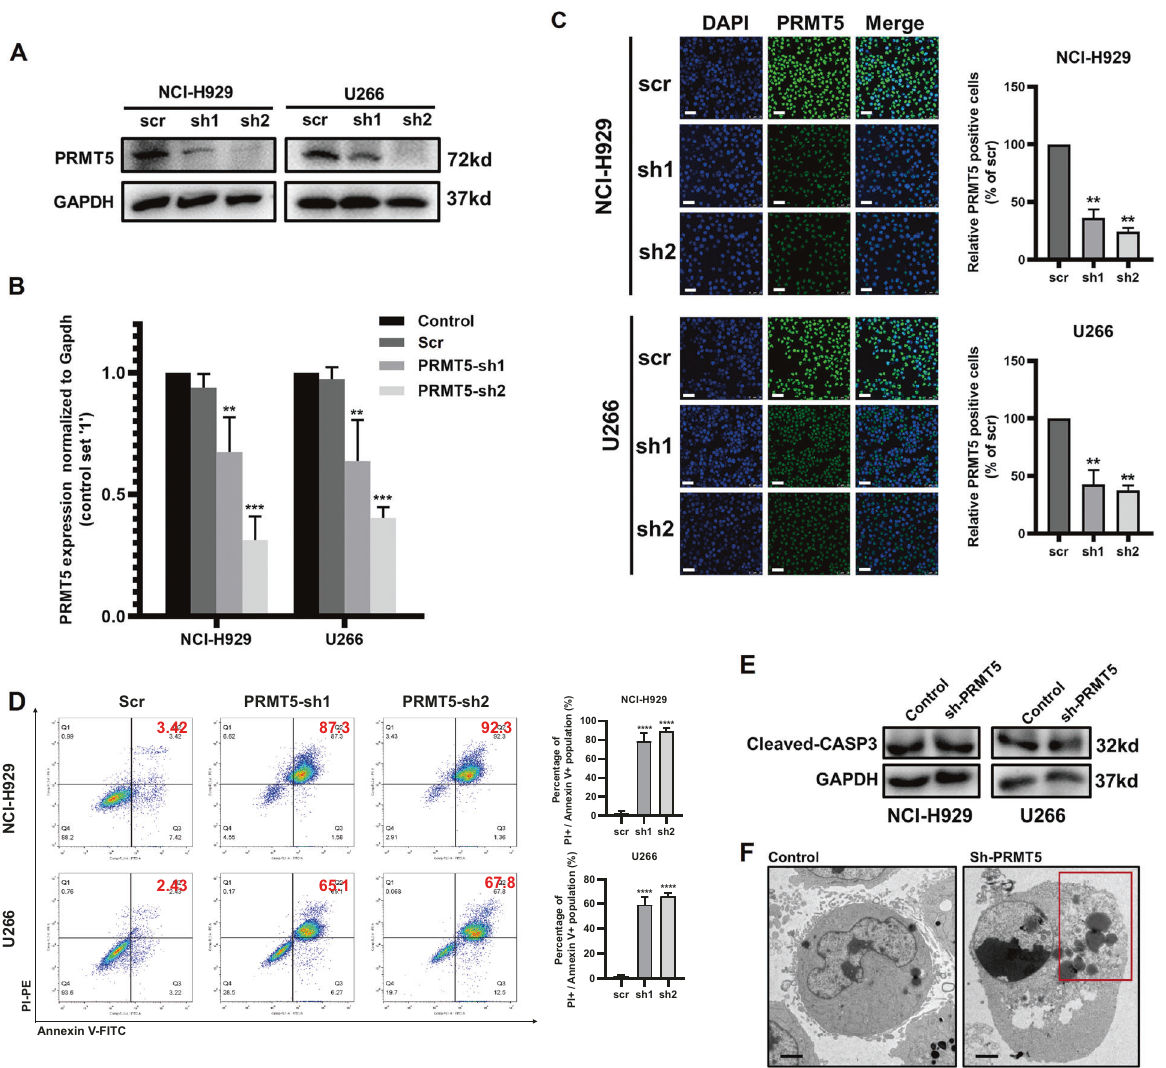
Fig. 2 PRMT5 activates pyroptosis of MM cell lines. A – C PRMT5 knockdown was detected in NCI-H929 and U266 cells stably expressing the scrambled control (scr) or PRMT5 shRNA (PRMT5 sh1/2) by western blotting, qRT-PCR, and immuno fl uorescence assay. Scale bar = 25 μ m. D The analysis of Annexin V-FITC and PI by fl ow cytometry in NCI-H929 (upper panel) and U266 (lower panel) cells stably expressing the control or PRMT5 shRNA. E Expression level of cleaved-CASP3 in shPRMT5 cells and negative control cells via western blotting. F Representative images of electron microscopy analysis of pyroptosis morphology changes in NCI-H929 cells. Scale bar = 2 μ m. Data shown are mean ± SD ( n = 3). ** P < 0.01, *** P < 0.001, **** P <